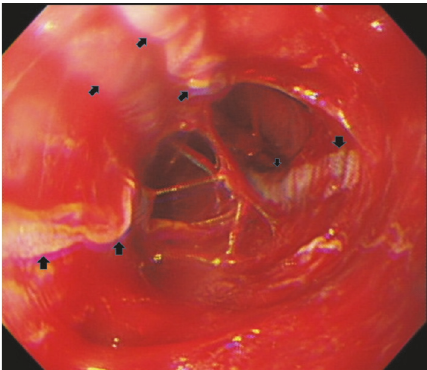
Figure 1: Initial endoscopy view (postthermal injury day 1). A dif- fuse corrosive surface with longitudinal thin, exuding, white merely scaling membranes (arrow), intervening with friable, spontaneous bleeding